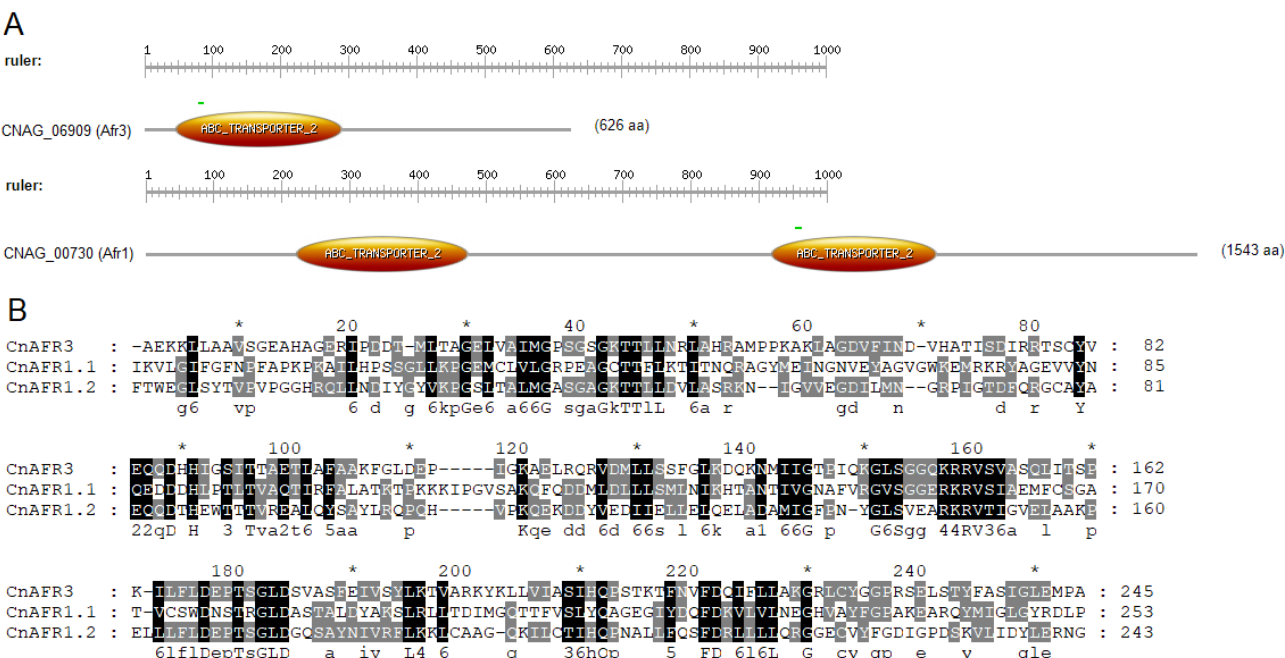
Figure 1. Afr3 ( CNAG_06909 ) Has Similar Motifs to Afr1 ( CNAG_00730 ). ( A ) Afr3 possesses one ATP-binding cassette (ABC) domain, an ATPase domain that utilizes ATP binding and hydrolysis to fuel the transport of different molecules across membranes, while Afr1 has two. The search was conducted using Prosite (https://prosite.expasy.org/scanprosite/; accessed on 3 Dec 2021); ( B ) alignment analysis between the ABC transporter domain of Afr3 (CnAFR3) and the two domains of Afr1 (CnAFR1.1 and CnAFR1.2) was performed with ClustalW, in the BioEdit program. The figure was generated using GeneDoc. Sequences in black are highly conserved.